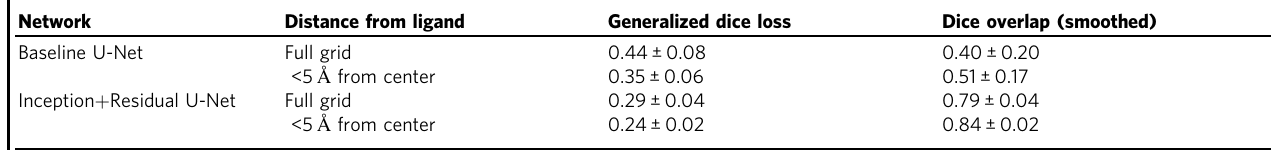
VariousmetricsfortheperformanceofabaselineU-NetandaU-NetusingInceptionandResidualblocks.Performanceonthevalidationsetsaredisplayed(shownasmean±standarddeviationofcross- validation trials). Metrics are shown for the grids covering the whole binding site and for the sub-grids focusing on the area within 5 Å of the ligand center. The results show that the Inception + Residual U-Net surpasses the baseline model ’ s performance.